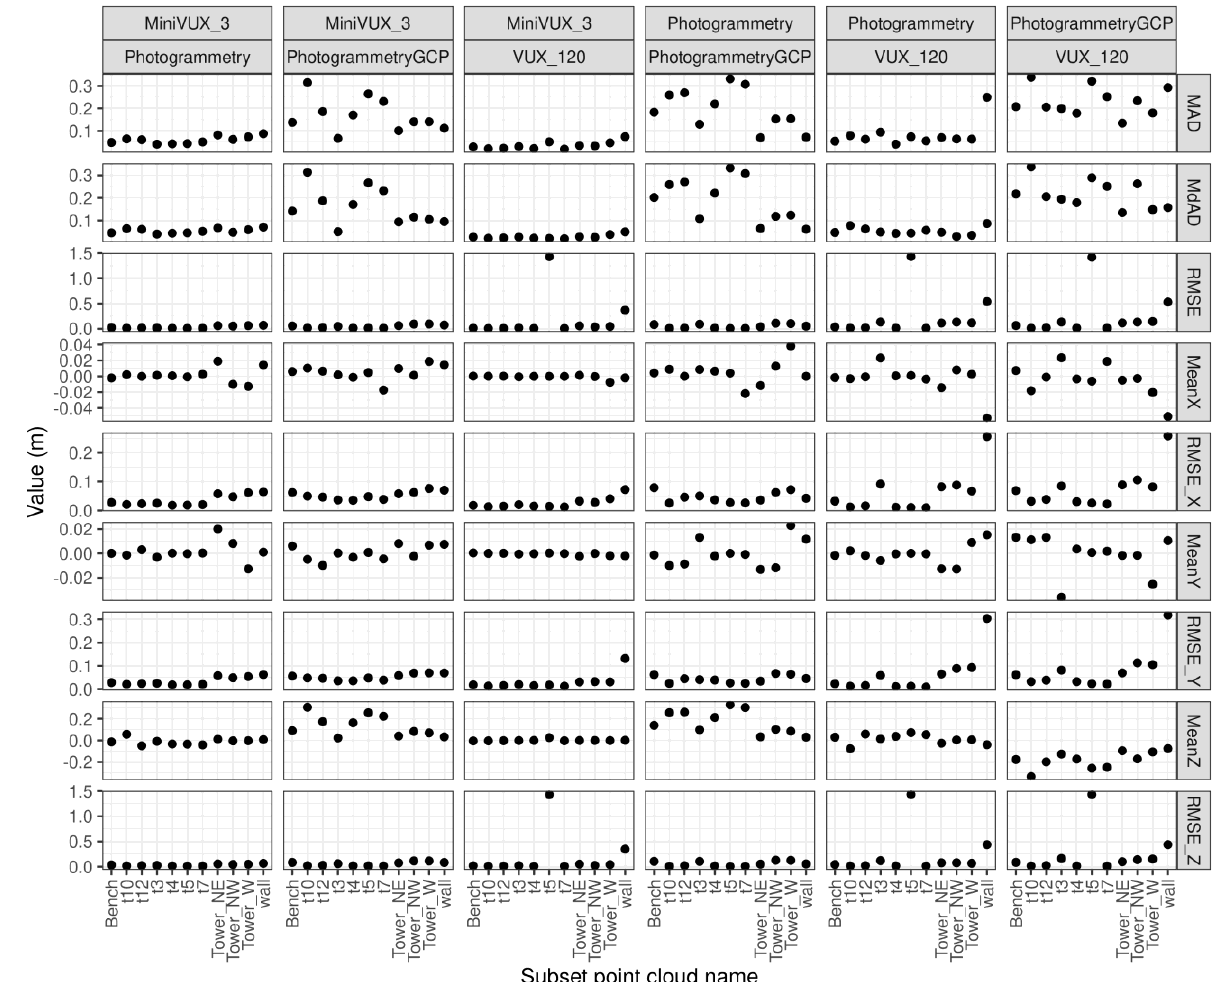
Figure 4. Analysis of differences using point-to-point nearest neighbour in image pairs. MAD = Mean absolute difference, RMSE = root mean square of differences, mean and standard deviation of differences in X, Y and Z